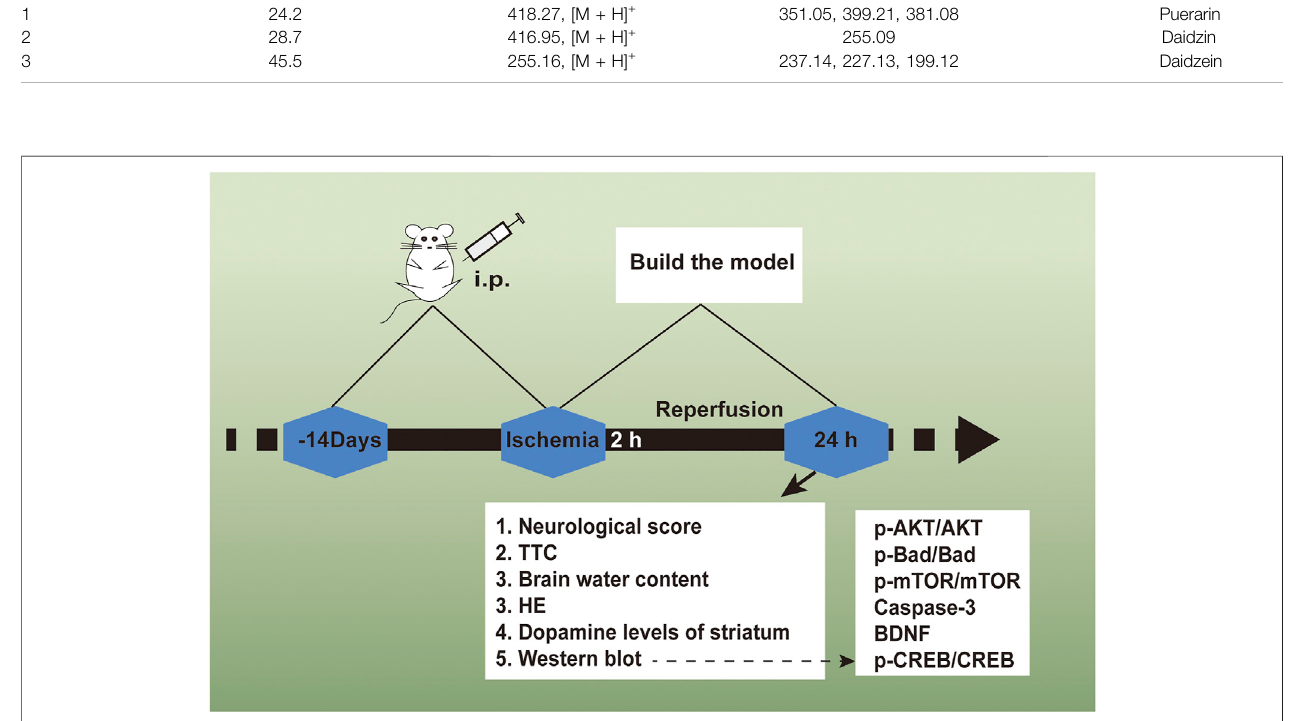
FIGURE 2 | The experimental fl ow chart of the protective effect exerted by Daidzein in ischemic stroke